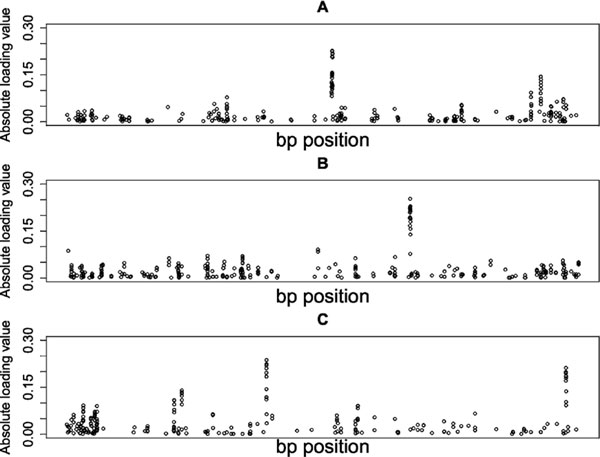
Visualizing single-nucleotide polymorphism profiles from the top 3 sparse principal components (PCs) associated with systolic blood pressure. (A) Sparse PC 11. (B) Sparse PC 9. (C) Sparse PC 19. Plots of the loading values for a PC to visually inspect genetic structure. bp, base-pair.